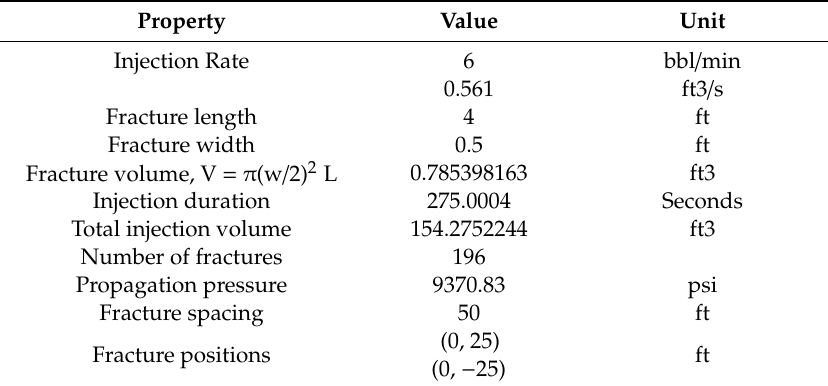
Table 6. Assumed injection and fracture volumetric parameters used in